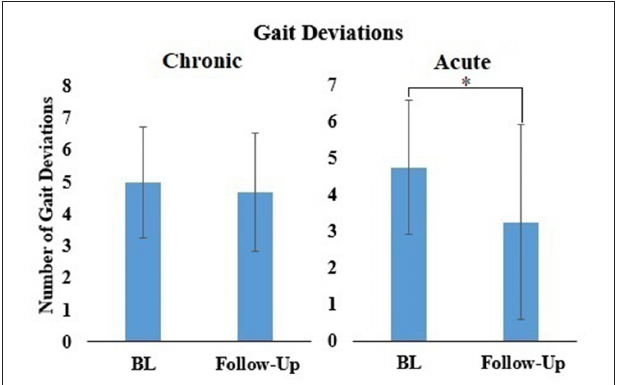
FIGURE 5 | Mean ± standard deviation of Gait deviations for all participants during baseline (BL) and follow-up for participants in the chronic and acute stage of stroke recovery. * p < 0.05.